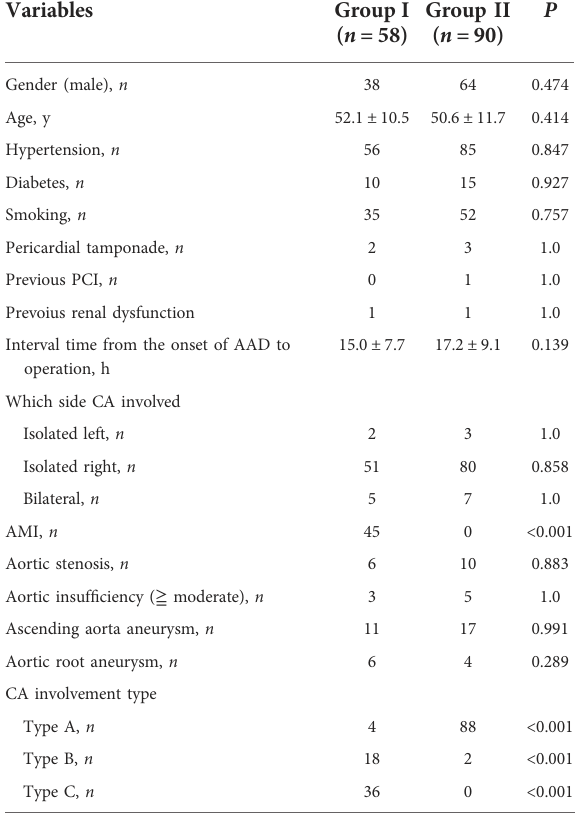
TABLE 1 Demographics and characteristics of